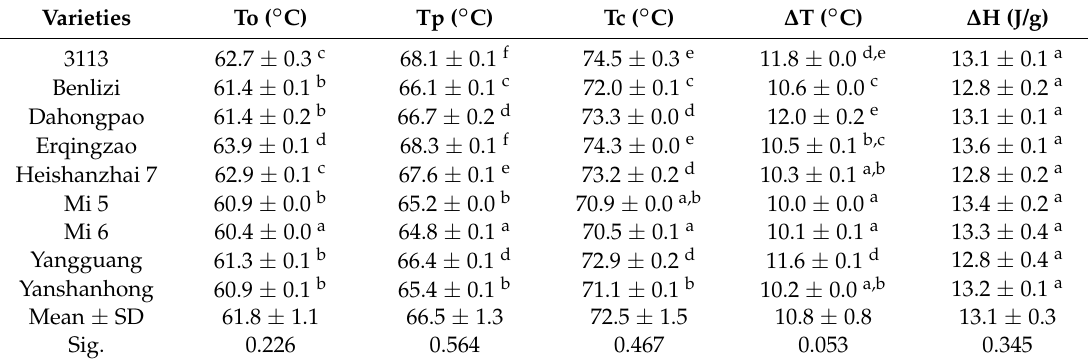
Table 4. Thermal parameters of starch.